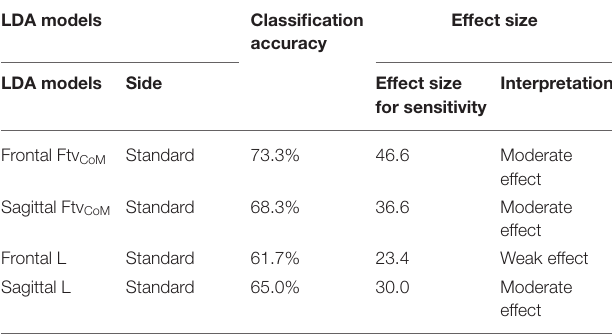
TABLE 3 | Linear discriminant analysis’ (LDA) effect size sensitivity (ESS).